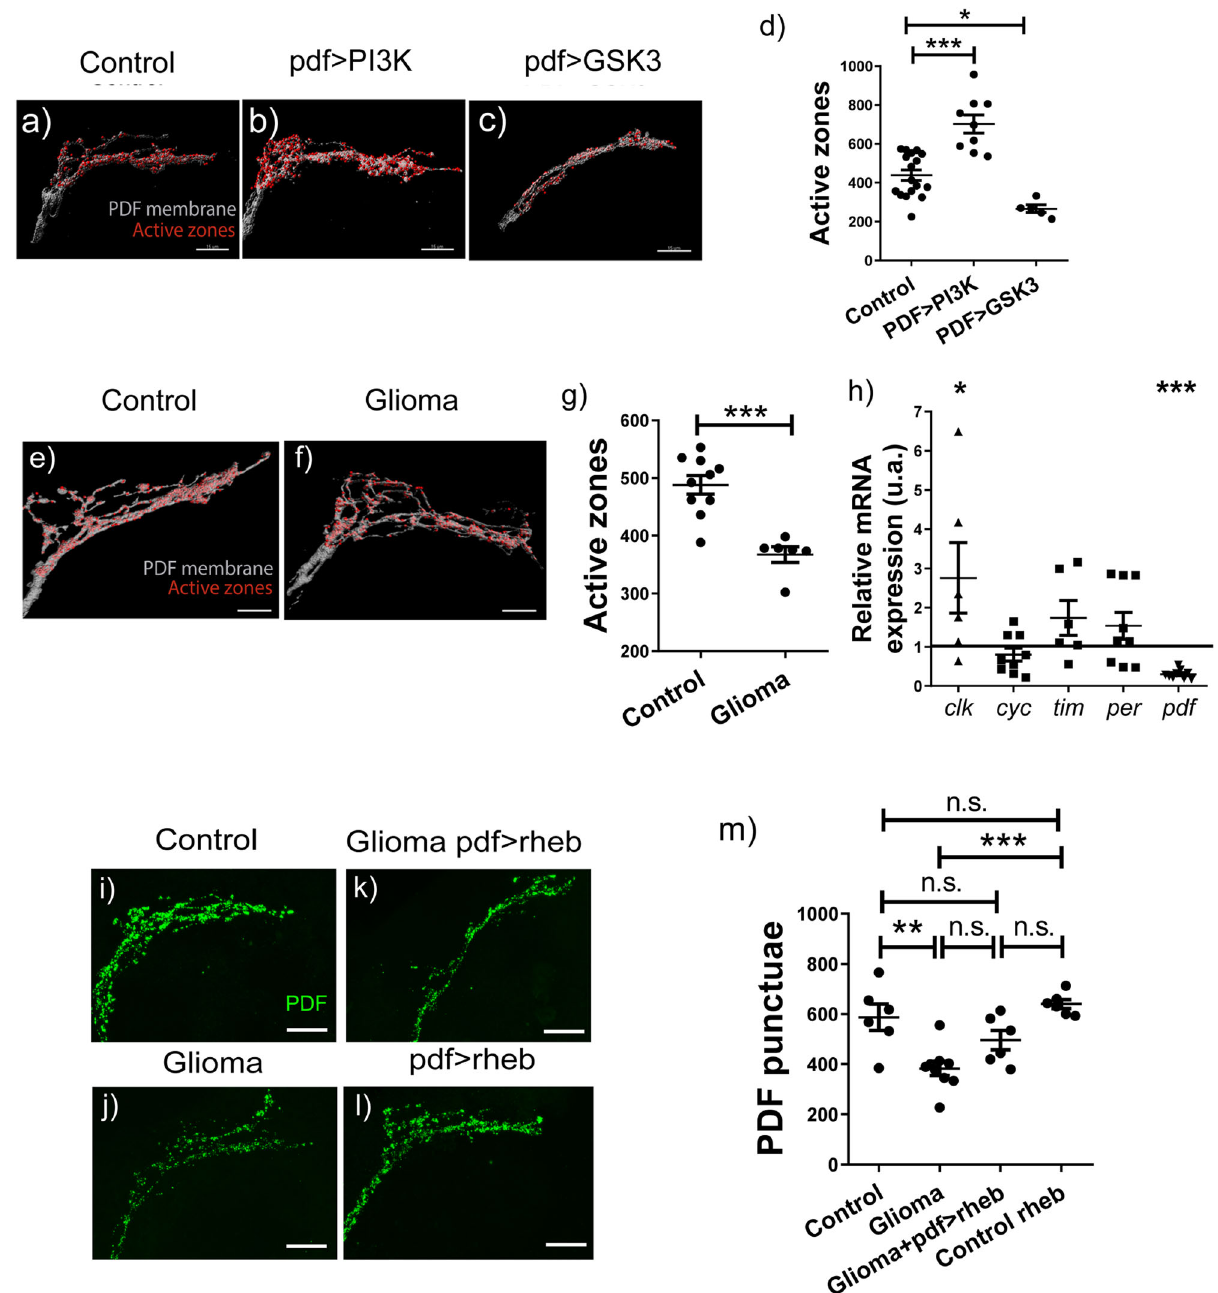
Fig. 2 GB-induced neurodegeneration of central pacemaker neurons. a – c Digital reconstruction of PDF neuron axonal terminal membrane of PDF neurons contacting DN1 neurons of ( a ) control, ( b ) PDF > PI3K and ( c ) PDF > GSK3. Axon terminal in white and active zones localized in their membrane in red (scale bar, 15 µ m). d Quanti fi cation and statistical analysis of active zones per animal in at least N = 5 fl ies (ANOVA, post-hoc Bonferroni) (*** p -value< 0,001). e , f Digital reconstruction of the axonal terminal membrane of PDF neurons contacting DN1 neurons of adult brains of ( e ) control and ( f ) glioma animals 7 days after tumor induction, with neuronal membrane in white and active zones in red. Digital reconstruction of PDF neurons axon terminal in white and active zones localize in their membrane in red (scale bar, 10 µ m). g Quanti fi cation of active zones per animal for at least N = 6 fl ies (t test) (*** p - value< 0.001). h RT-qPCR analysis of complete brains of adult fl ies (bearing a 7-day old GB) from control and glioma genotypes in L:D conditions at ZT6 for the circadian genes clk , cyc , tim, per and PDF , with at least 6 replicates per genotype ( t test) (* p -value<0,05, ** p -value<0,01, *** p -value<0,001). i – k Confocal images of PDF-neuronal contacts with DN1 stained with anti- pdf (green) of ( i ) control, ( j ) glioma, ( k ) rescued glioma (by means of rheb over- expression in PDF neurons) and ( l ) rescued healthy fl ies. m Quanti fi cation and statistical analysis of active zones per animal in at least N = 6 fl ies (ANOVA, post-hoc Bonferroni) (** p -value< 0,01).